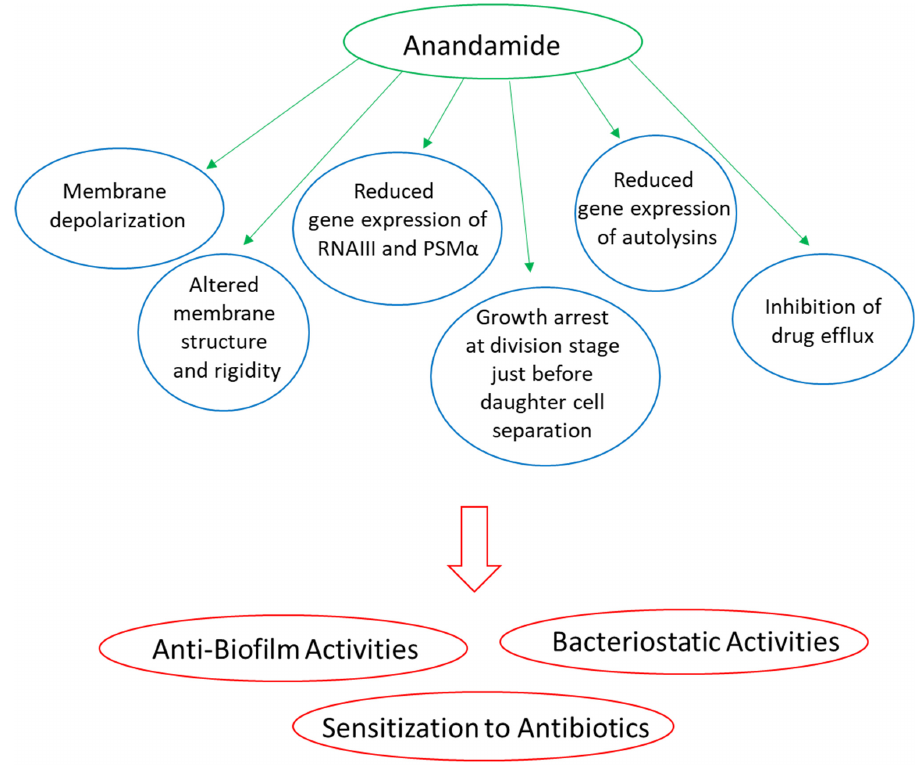
Figure 4. The anti-bacterial actions of anandamide on Staphylococcus aureus .